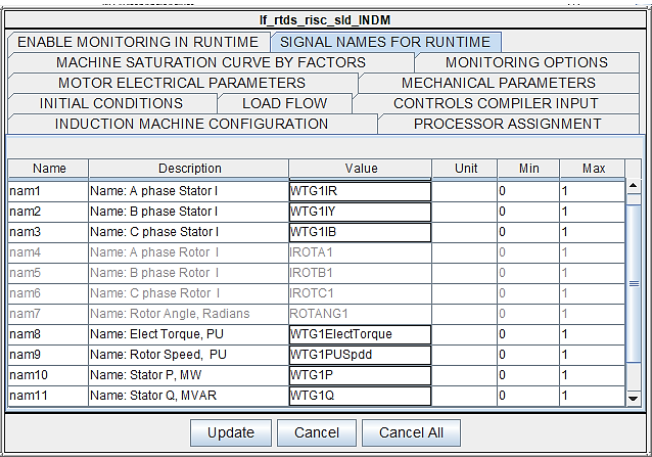
Figure 21. Signal name settings for induction generator model.